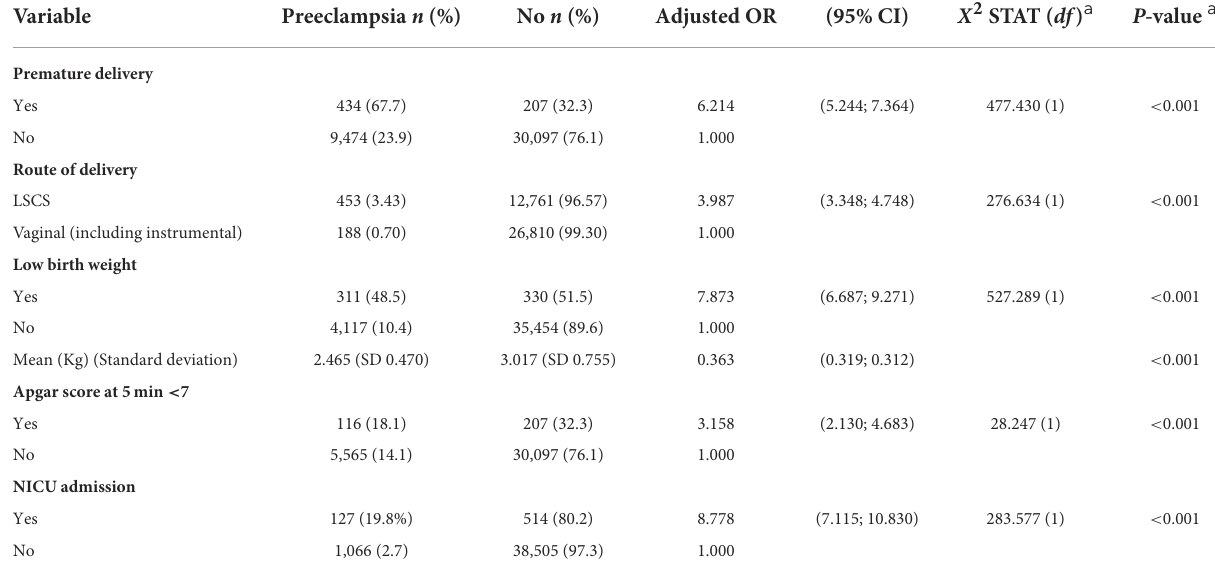
TABLE 4 Association of preeclampsia and adverse birth outcomes.